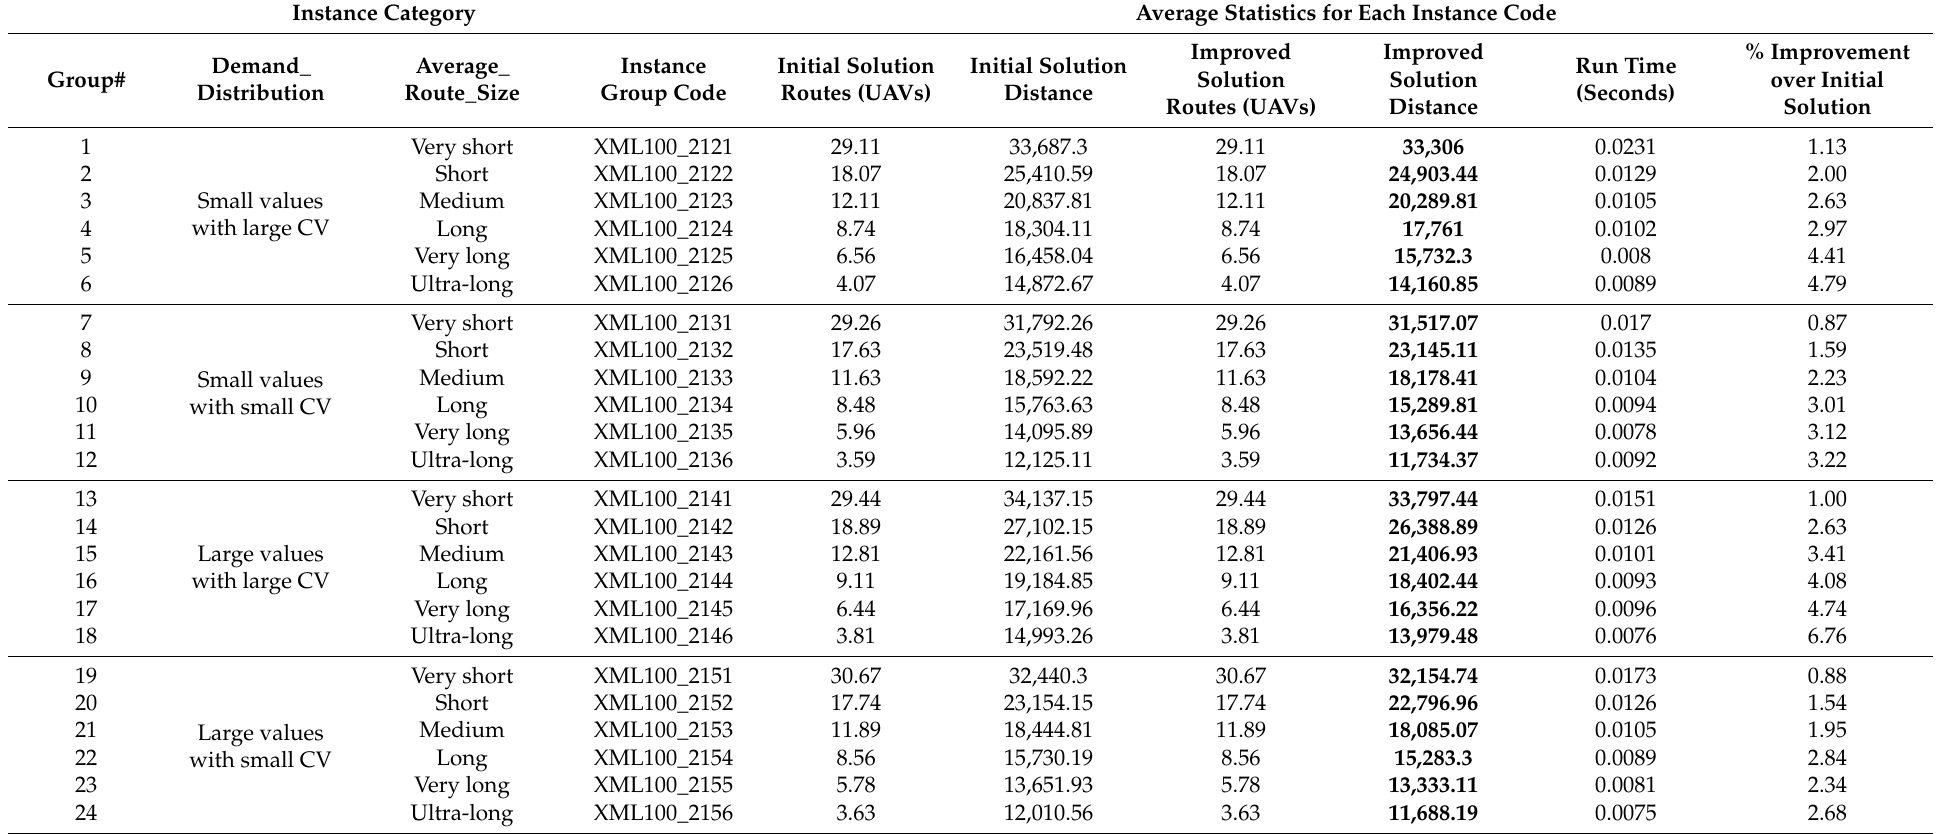
Table A1. Results of the GBCDH on the XML100 dataset with centered depots and random customer positioning. The bold font indicates values that offer improvements from the initial solution distance to the final solution